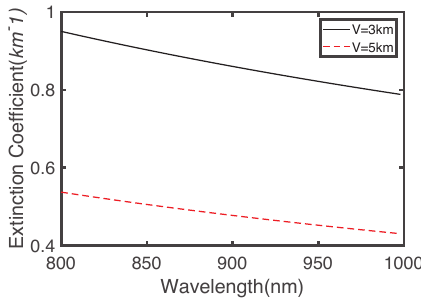
Figure 5. Extinction coefficient.